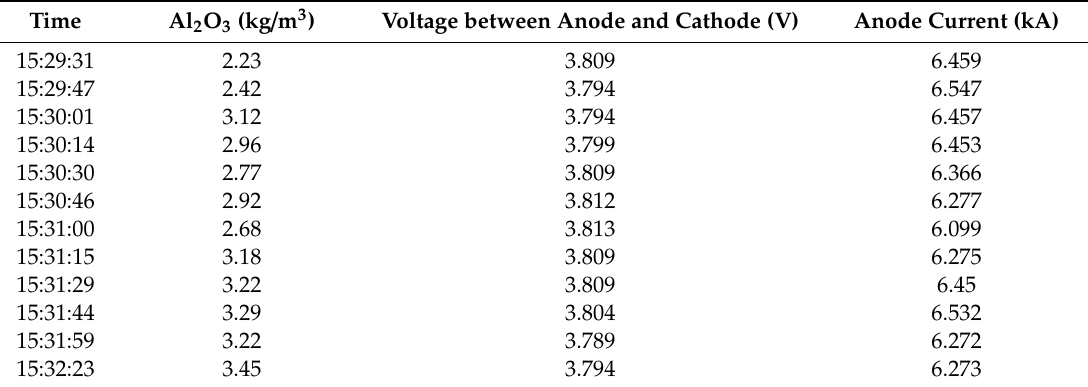
Table 2. Data fitting by cubic spline